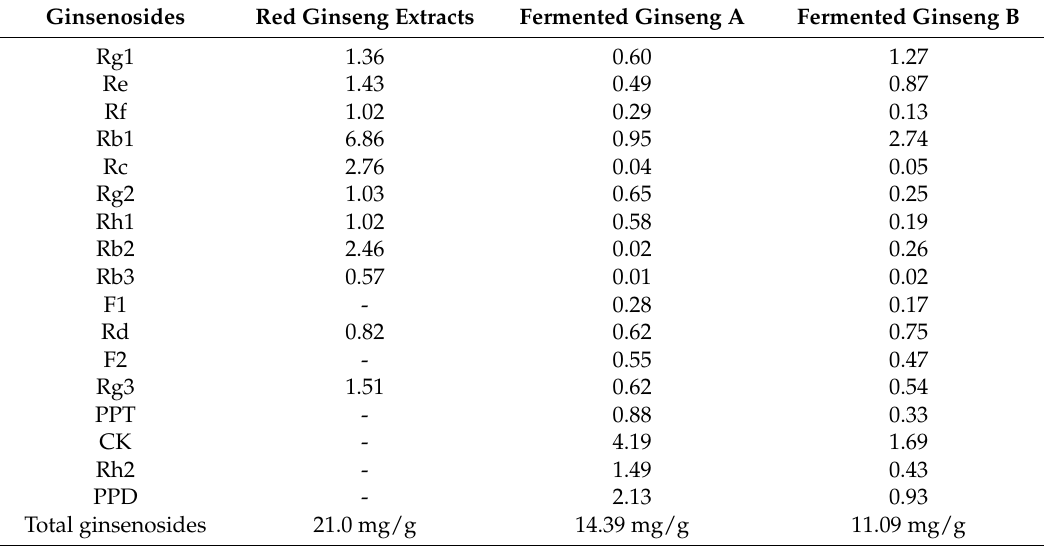
Table 1. Components of ginseng samples